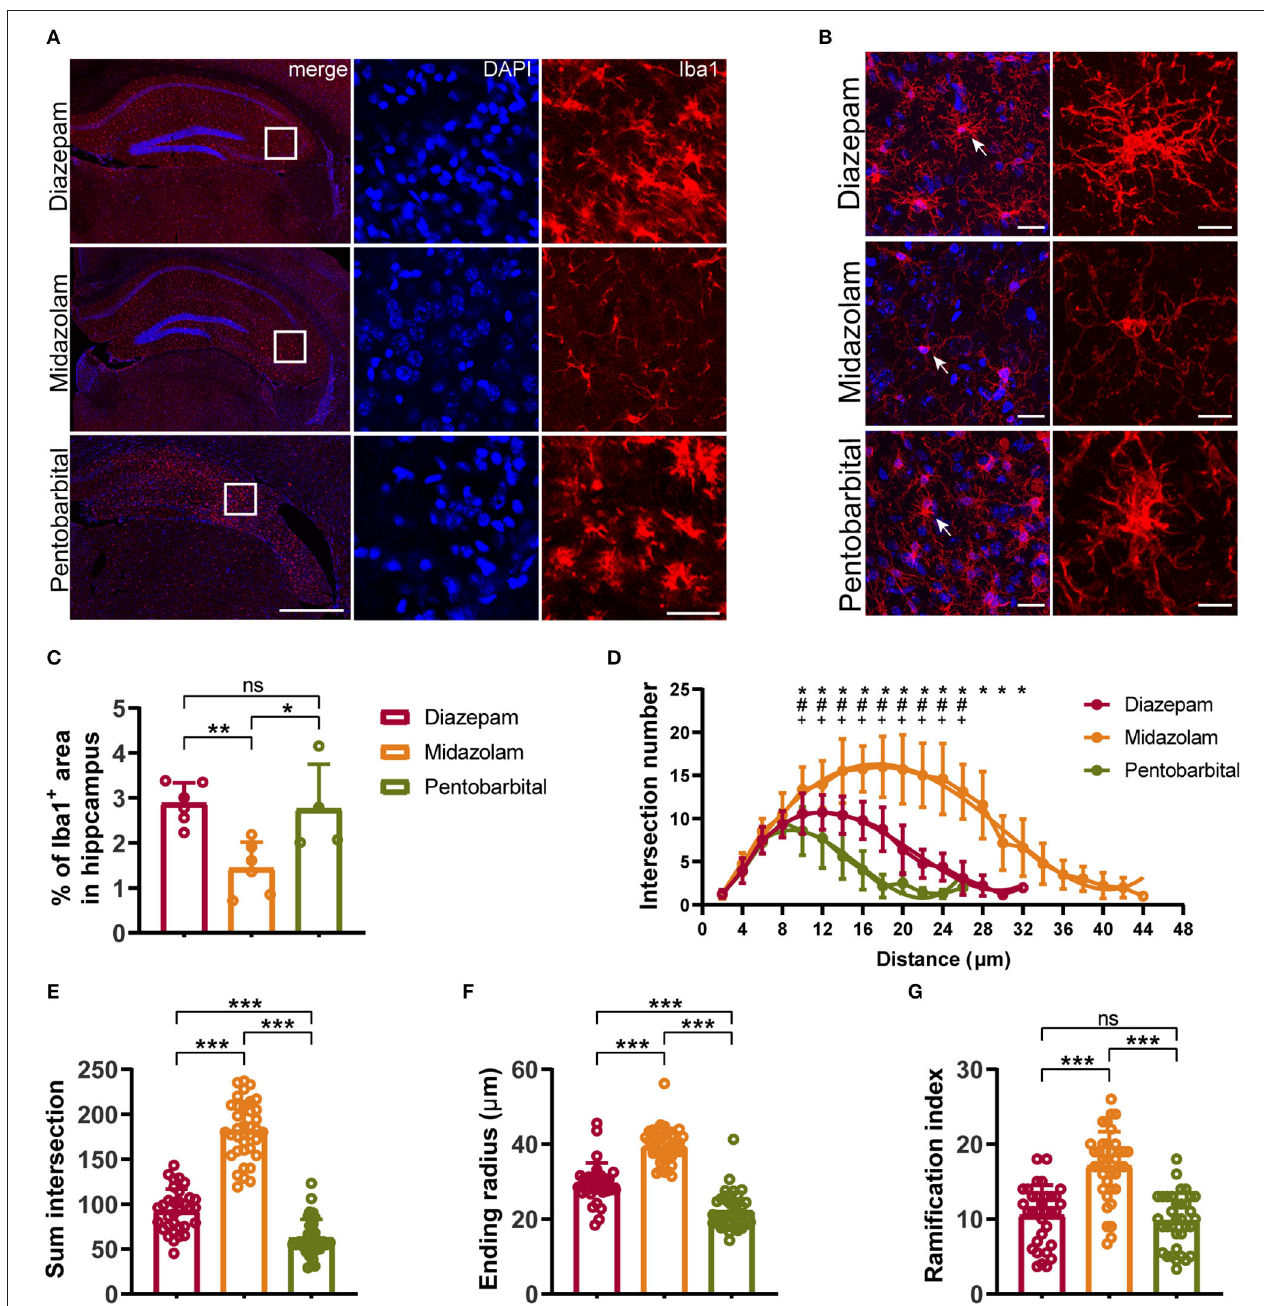
FIGURE 5 | Immunohistochemical staining showing differential hippocampal microgliosis 9 weeks after SE received different treatments. (A, B) Representative staining for microglia (Iba1 + ) of diazepam, midazolam, and pentobarbital groups. Scale bar in (A): left, 500 µ m; right, 100 µ m. Scale bar in (B) : left, 20 µ m; right, 10 µ m. (C) Statistics of percentage of Iba1 + area in hippocampus. (D) Summary number of intersections as a function of the radial distance from soma by 2 µ m increments showed that Iba1 + cells of midazolam group ( n = 22) had greater numbers of ramifications than diazepam ( n = 16) and pentobarbital ( n = 21) groups at 10–38 µ m distances from the soma. Diazepam vs. midazolam, * p < 0.05; diazepam vs. pentobarbital, # p < 0.05; midazolam vs. pentobarbital, + p < 0.05; two-way ANOVA with Tukey’s multiple comparisons test. (E) Summary number of intersections per Iba1 + cell (diazepam, n = 33; midazolam, n = 37; pentobarbital, n = 35). (F) Length of maximum branch (ending radius) of Iba1 + cells (diazepam, n = 33; midazolam, n = 37; pentobarbital, n = 35). (G) Ramification index of Iba1 + cells (diazepam, n = 33; midazolam, n = 37; pentobarbital, n = 35). One-way ANOVA with post-hoc Tukey’s multiple comparisons test, * p < 0.05, ** p < 0.01, *** p < 0.001, ns indicate no significant difference. Data were presented as mean ±